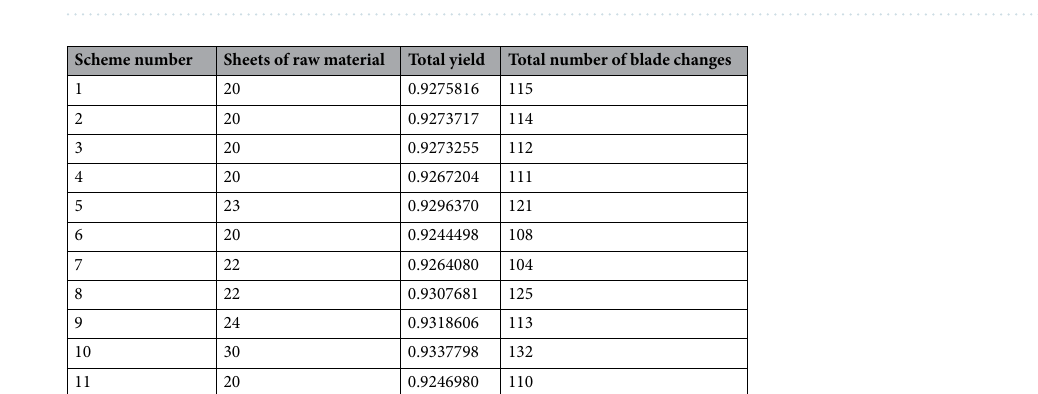
Figure 24. Genetic fitness curves.